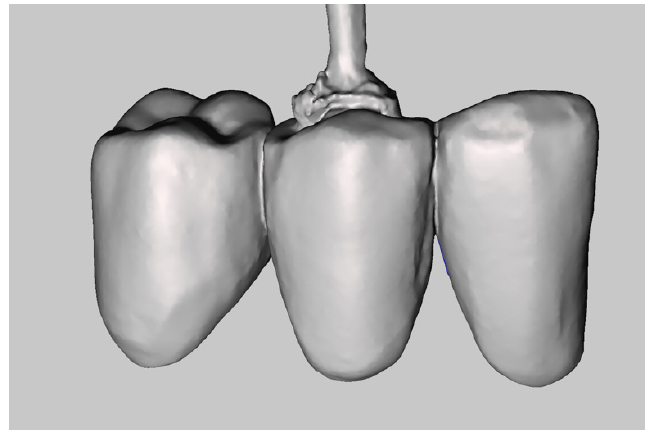
Figure 4. Digital impression of the abutments.